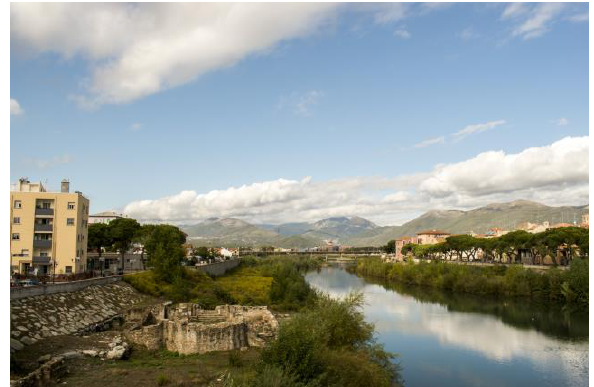
Figure 8. The archaeological site San Clemente in the Centa riverbed, always (partially) flooded 2.6 Management plan (Synthesis) and Implementation (Action)